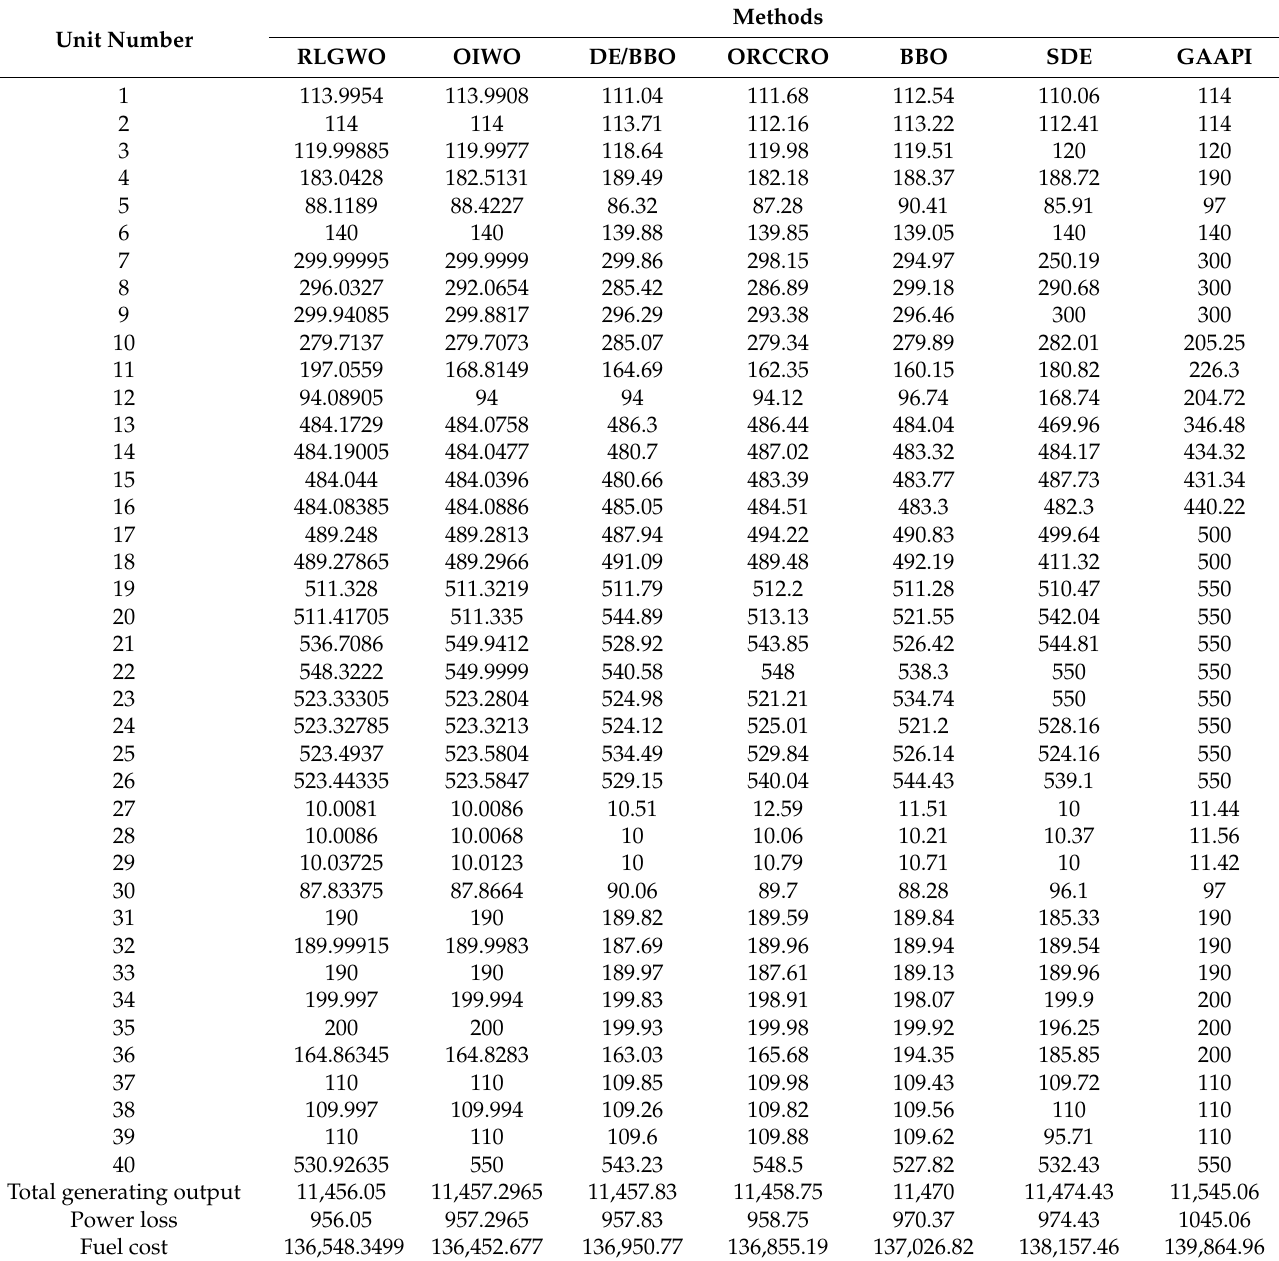
Table 3. Best simulation results for the 40-unit system with loss ( P D = 10,500